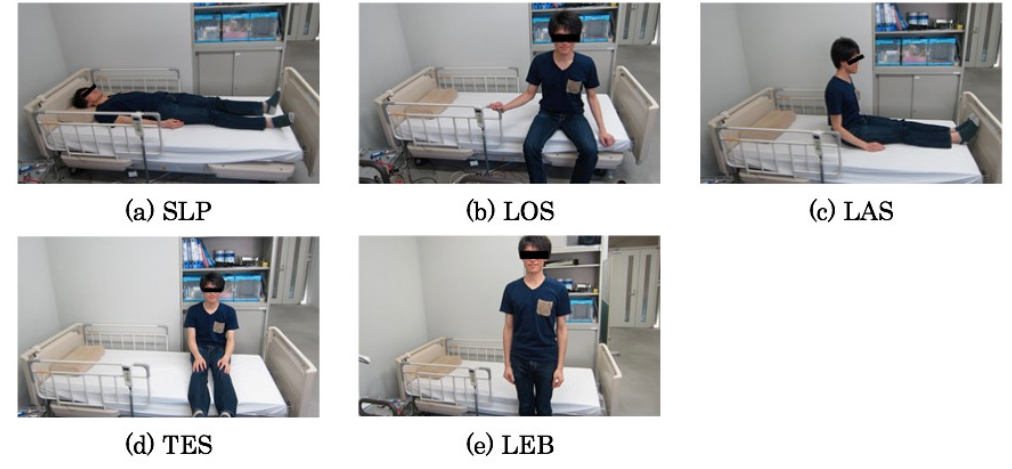
Figure 12. Target behavior